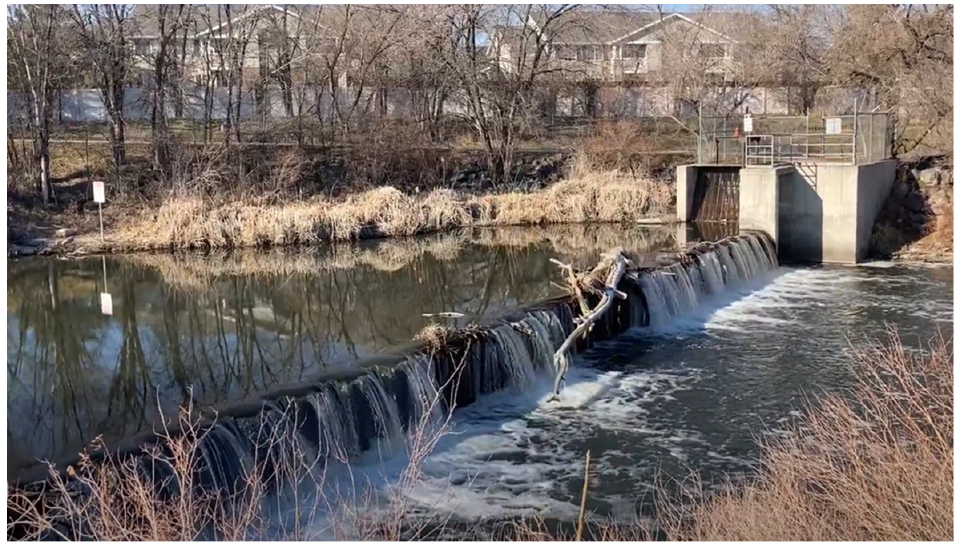
Figure 1. Low head dam used for diversion in Taylorsville, Utah. A site with a single fatality.